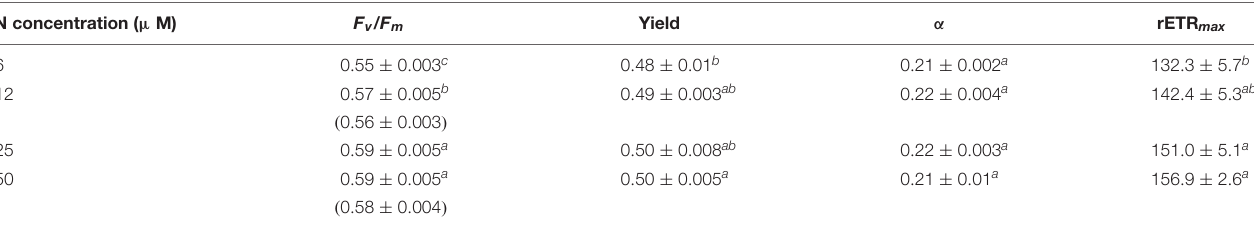
TABLE 2 | The maximum quantum yield ( F v / F m ), effective quantum yield (Yield), apparent electron transfer efficiency ( α ), and maximum relative electron transfer rate (rETR max ) of Gephyrocapsa oceanica cells grown under different nitrate